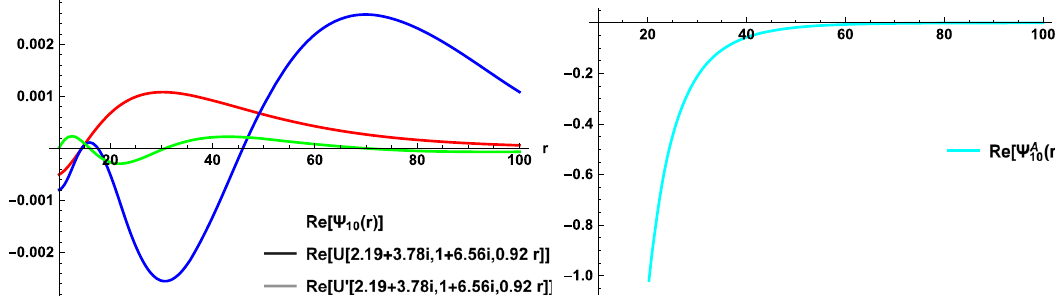
Fig. 5 Local maximum potential V dRN ( r ) (cid:17) V adR ( r ) as function of r ∈ [ r + = 1 . 77 , 100 ] with M = 1 , Q e = 0 . 4 , Q m = 0 . 5 ,ω = 0 . 02 , q = 10 , l = 5 ,μ = 0 . 05. We note ω < μ and ω < ω c ( = 2 . 26 )